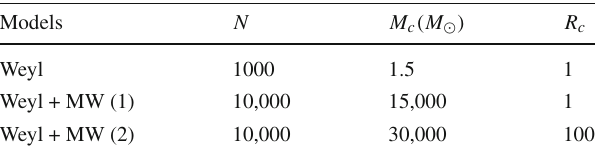
Table 2 The adopted parameters in N-body simulation, where the clus- ter mass M c is in sun mass units M (cid:8) Models N M c ( M (cid:2) ) R c Weyl